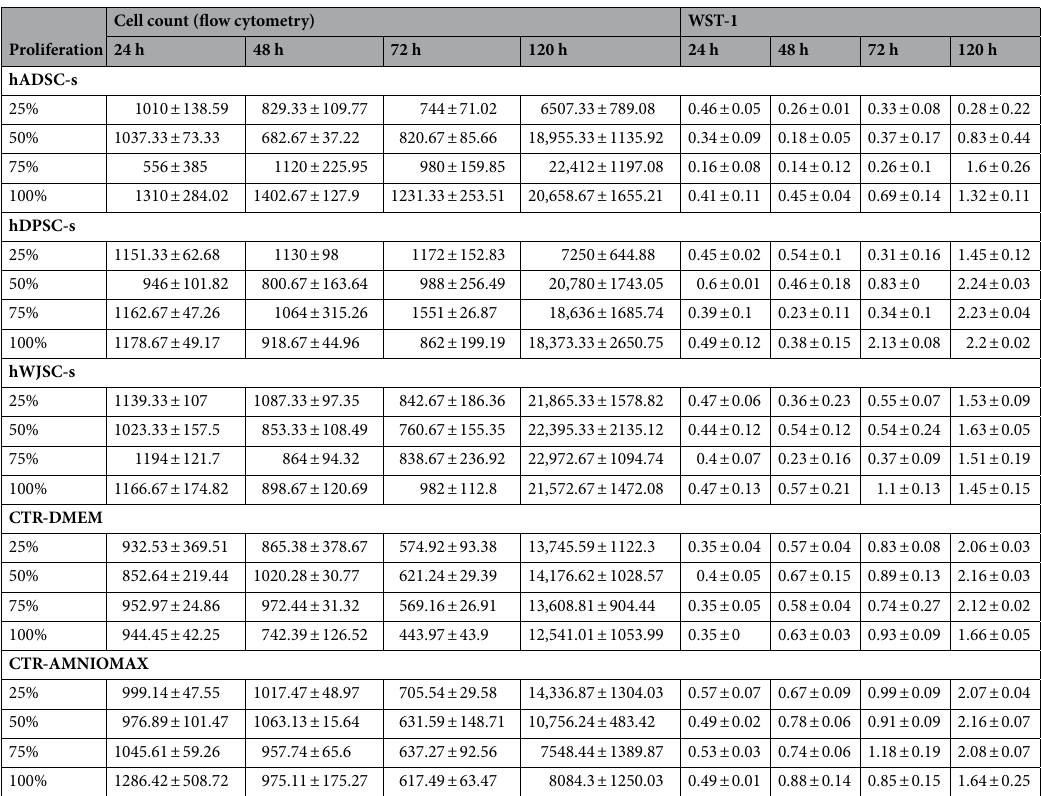
Table 3. Analysis of cell proliferation as determined by sequential cell counting with flow cytometry and WST-1 activity in HSEC exposed to different types (hADSC-s, hDPSC-s and hWJSC-s) and concentrations (25%, 50%, 75%, 100%) of secretome, or to control (CTR) nonconditioned medium (AMNIOMAX-C100 or DMEM) after 24, 48, 72 and 120 h of follow-up. Results are shown as averages ± standard